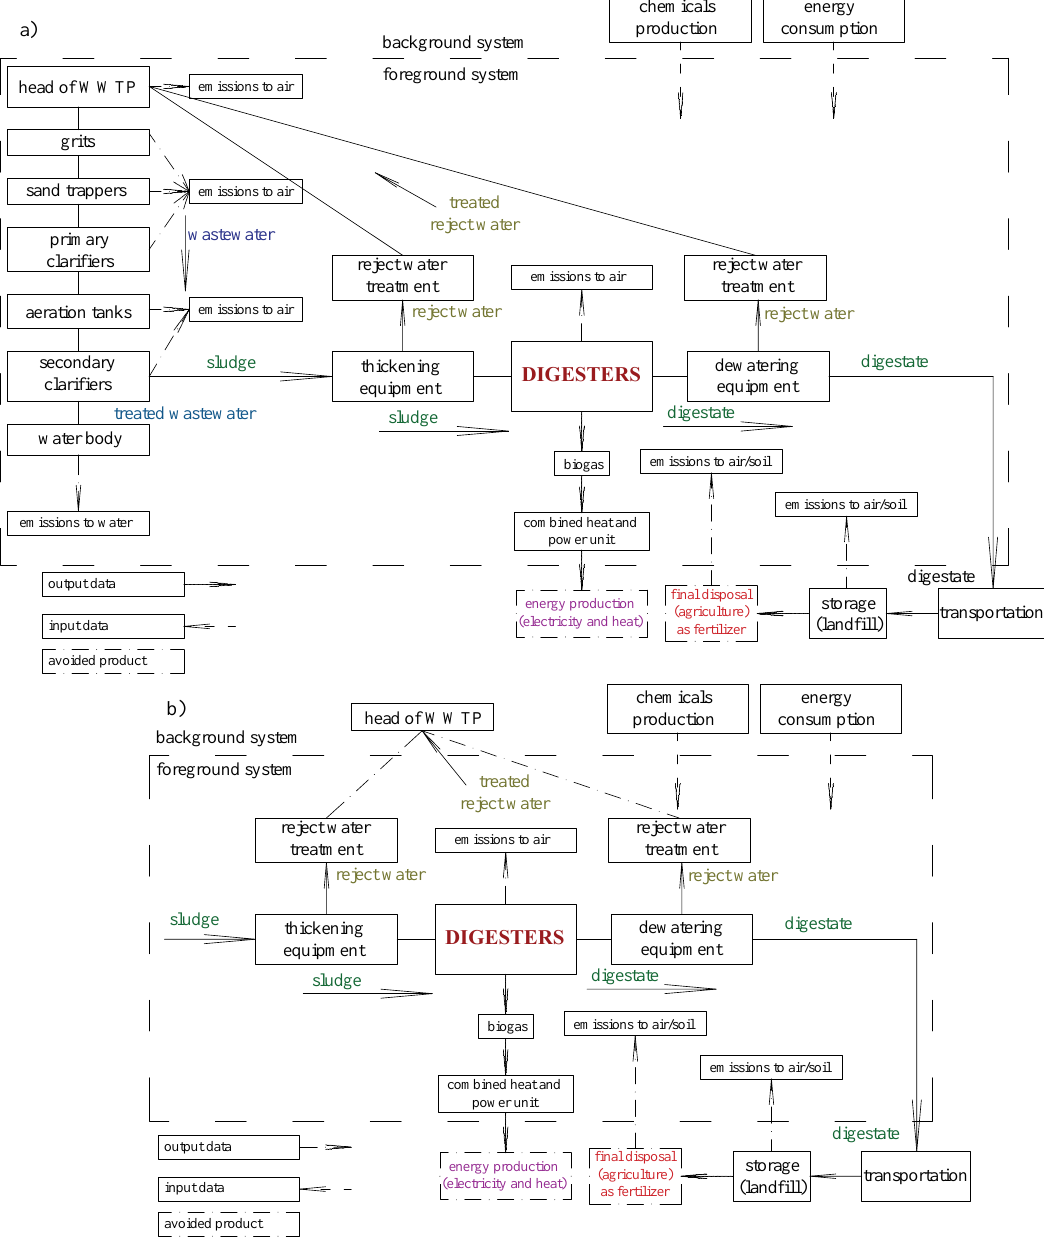
Figure 1. Flowcharts: ( a ) for life cycle assessment of the whole wastewater treatment plant (WWTP- Figure1. Flowcharts: ( a )forlifecycleassessmentofthewholewastewatertreatmentplant(WWTP-LCA) LCA) and ( b ) for life cycle assessment of the sludge line alone (SL-LCA). and ( b ) for life cycle assessment of the sludge line alone